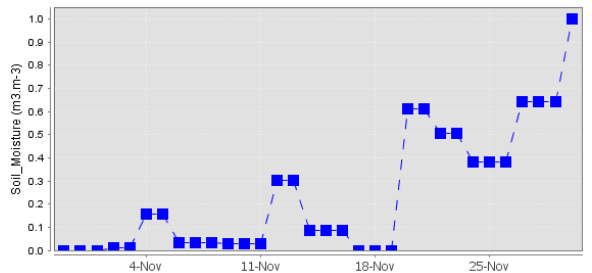
Figure 7. SM Time Series of Guelmim during November 2014